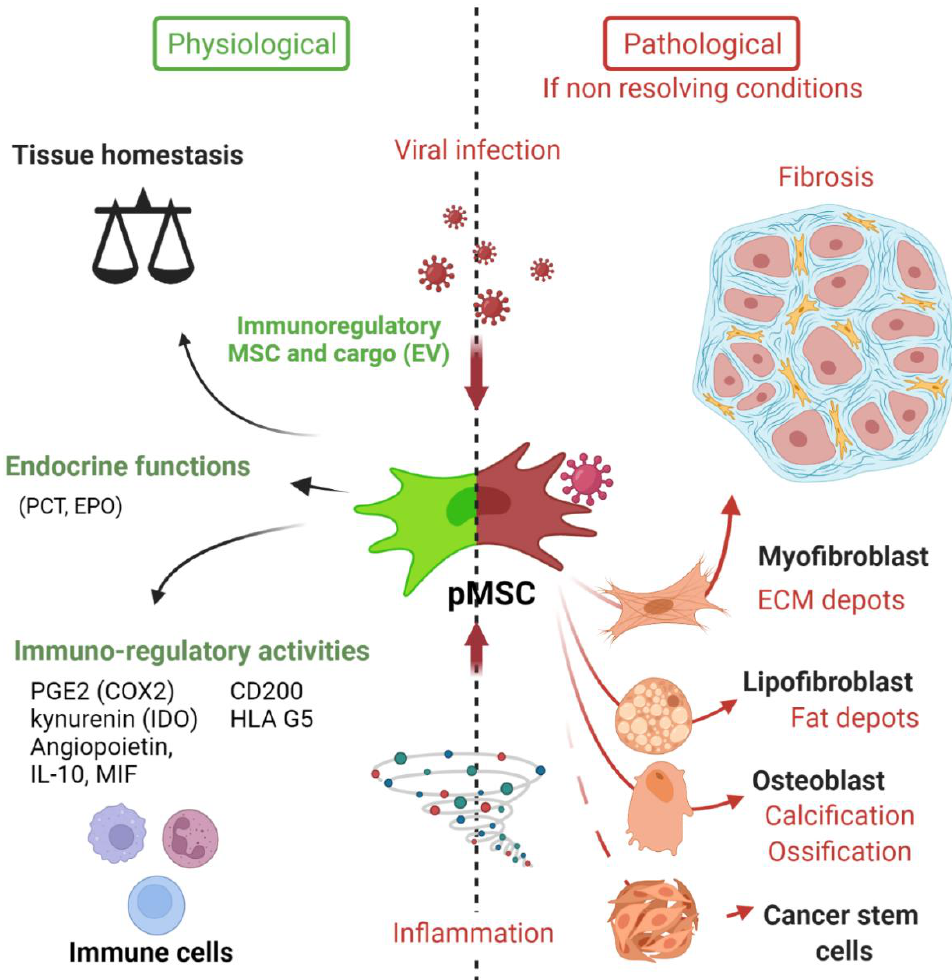
Figure 2. Deciphering the role of Mesenchymal stem cells in the context of viral infection. In physiological conditions, MSC have important immune functions to control viral infection as glatekeepers around vessels (perivascular MSC) and capable of mounting an innate immune antiviral response. MSC will also promote release of cytokines and chemokines to recruit immune cells to clear pathogens. Equally important is the expression of many immune regulatory factors to terminate the adaptive immune response to limit further cell injuries and promote tissue repair. Many viruses may infect directly MSC in tissues, thus remaining in an immunoprivileged niche favoring virus persistence, spreading and possible virus rebound in immunocompromised patients. Viruses associated to chronic inflammation (non-resolving) may also affect MSC differentiation (e.g., into myofibroblast) leading to excess of extracellular cell matrix production and contributing to organ dysfunction. Importantly, allogenic MSC and derived extracellular vesicles (EV) are nowadays important immunoregulatory cargo injected to patients for the treatment of inflammatory-infectious diseases such as COVID-19. Safety issues are nevertheless highly warranted. PCT (pro-calcitonin); EPO (erythropoietin) hormones. These actions on the immune system involve both contact-dependent and contact- independent mechanisms. Indeed, MSCs have been shown to have effects on cell survival,